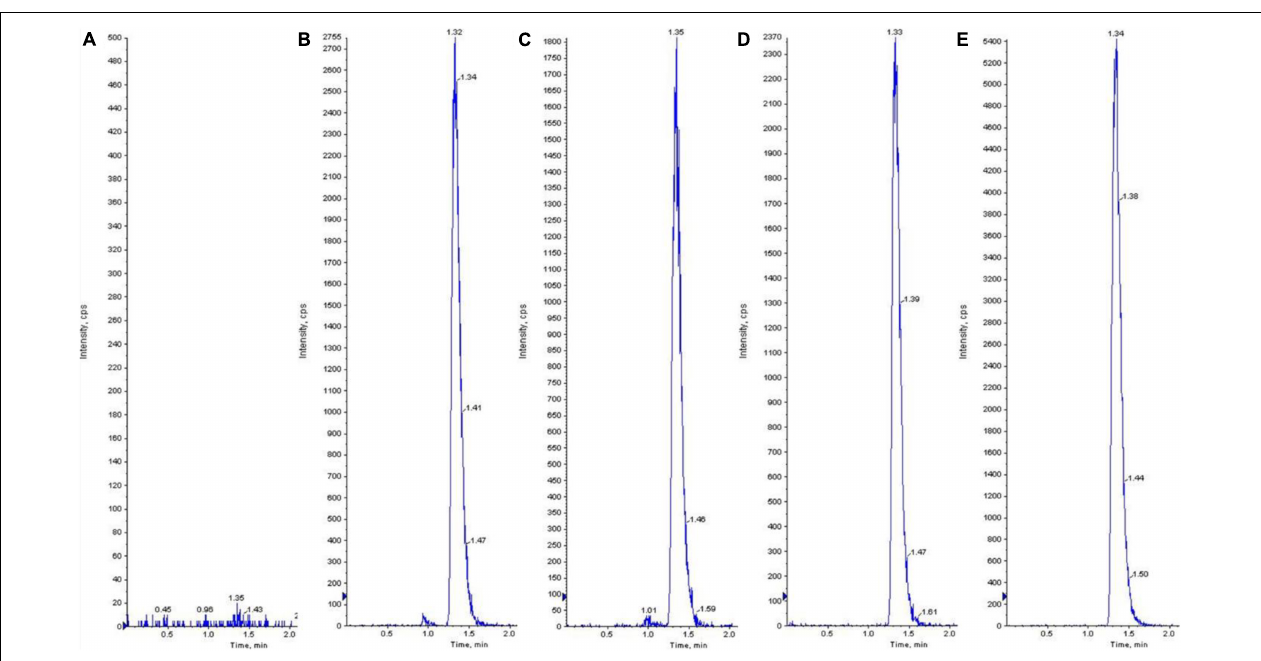
respectively, compared with the H1 group, whereas the Cr levels significantly decreased.